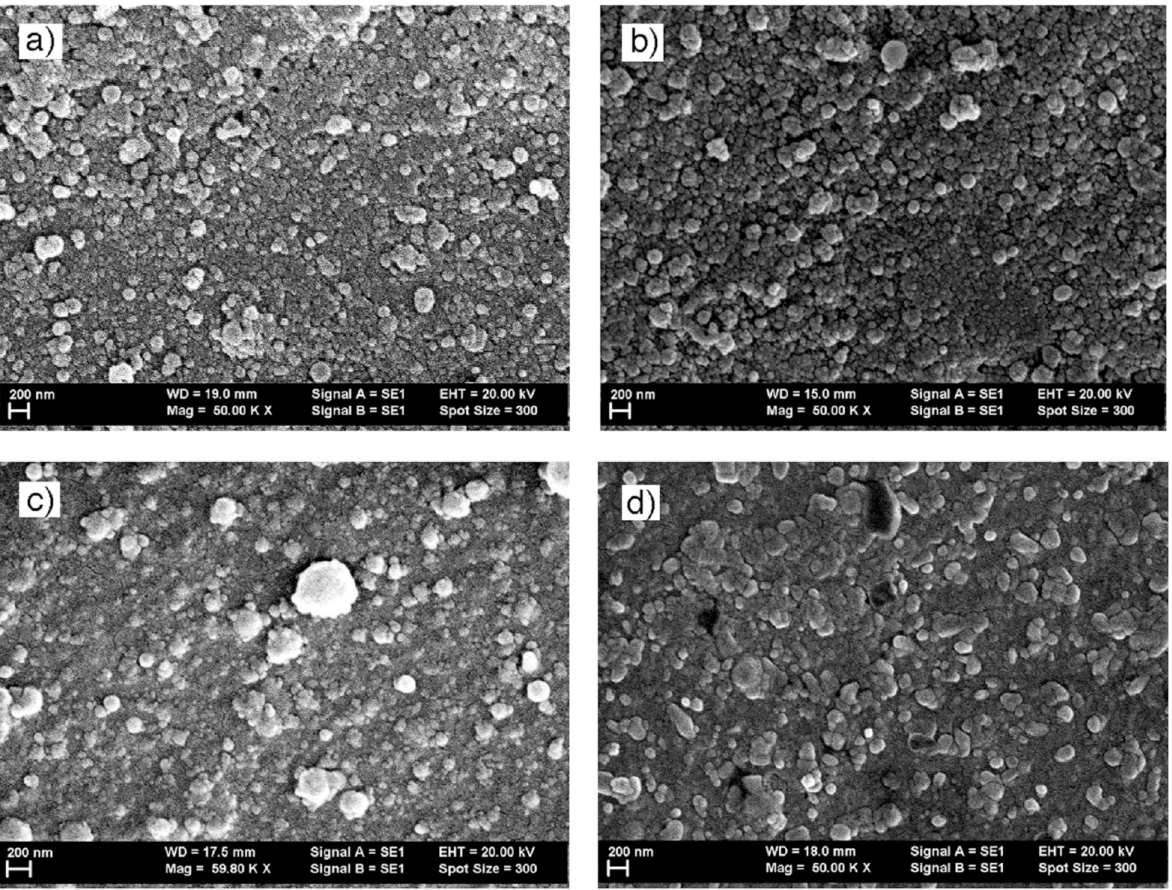
Figure 7. SEM images of LV5:C61 films deposited using MAPLE on ITO/glass substrate in different weight ratio and solvents: ( a ) (1:1), chloroform; ( b ) (1:2), chloroform; ( c ) (1:1), DMSO; ( d ) (1:2), DMSO. Reprinted with permission from [123]. Copyright 2017